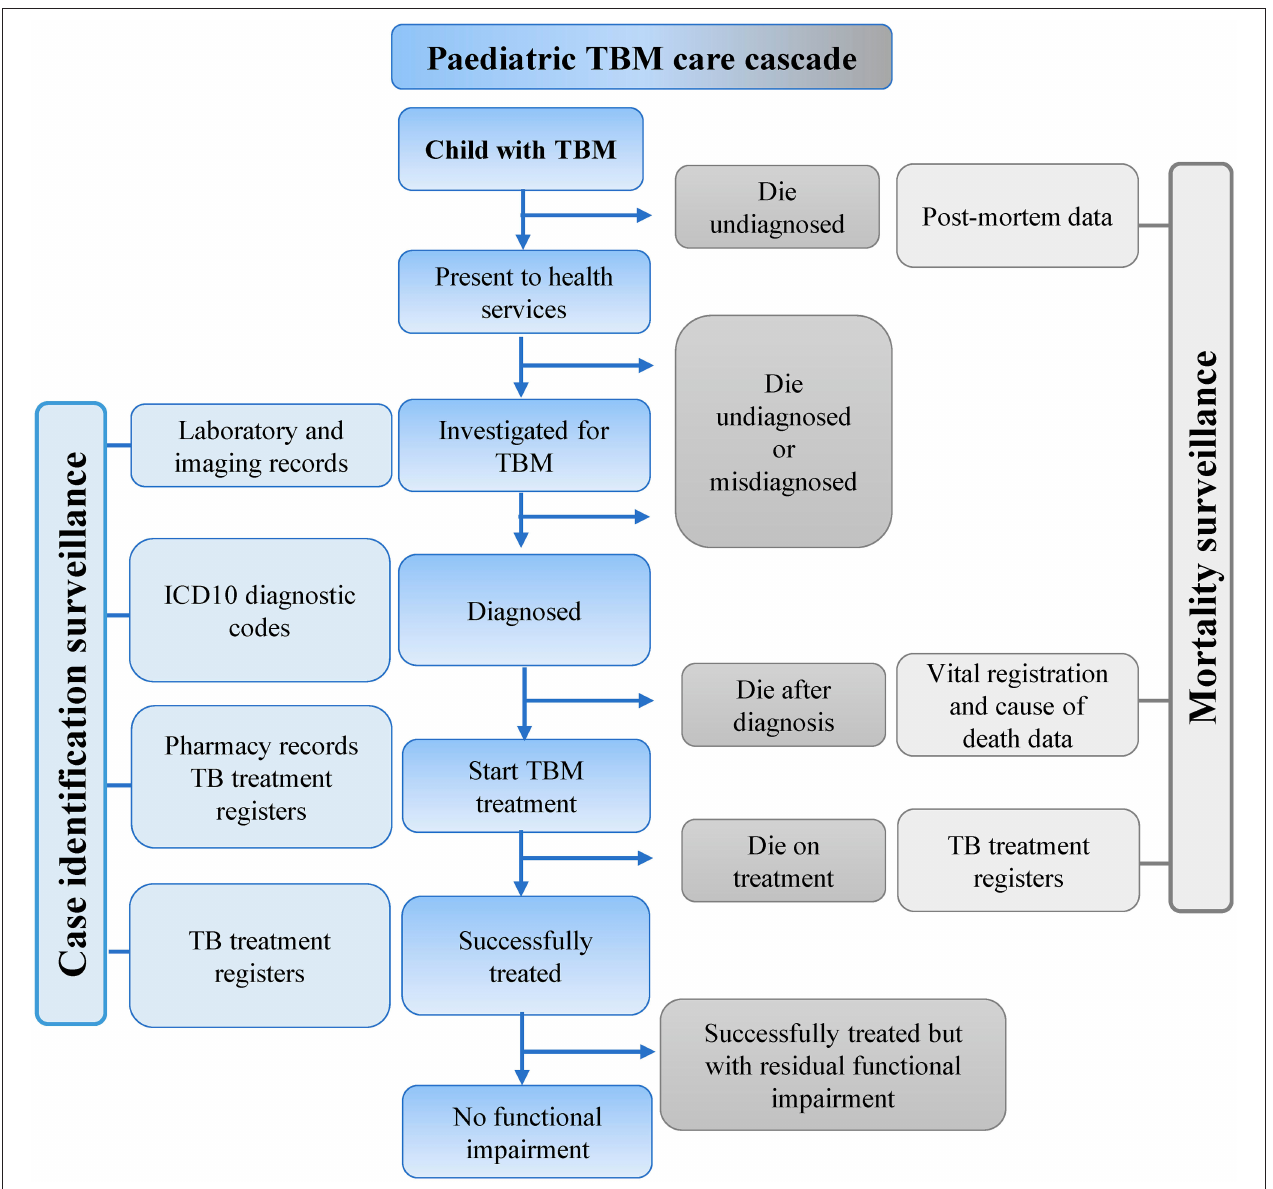
FIGURE 3 | Possible sources of data to inform a pediatric TBM care cascade. TBM, Tuberculous meningitis; ICD, International classification of diseases; TB,